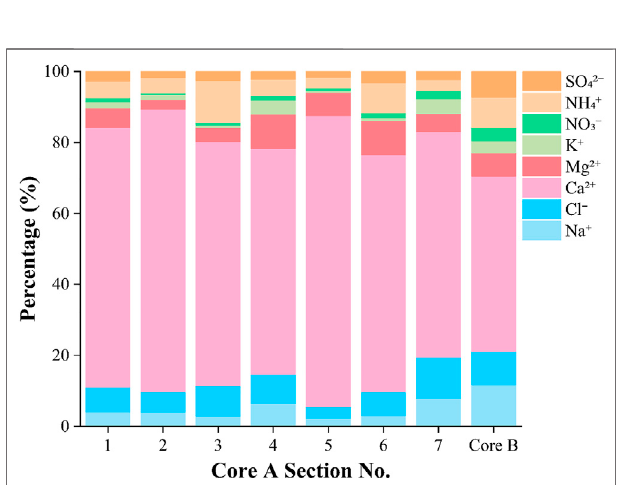
FIGURE4| Meancompositions(inEq)ofmajorchemicalsolutesineach section of Core A and Core B.